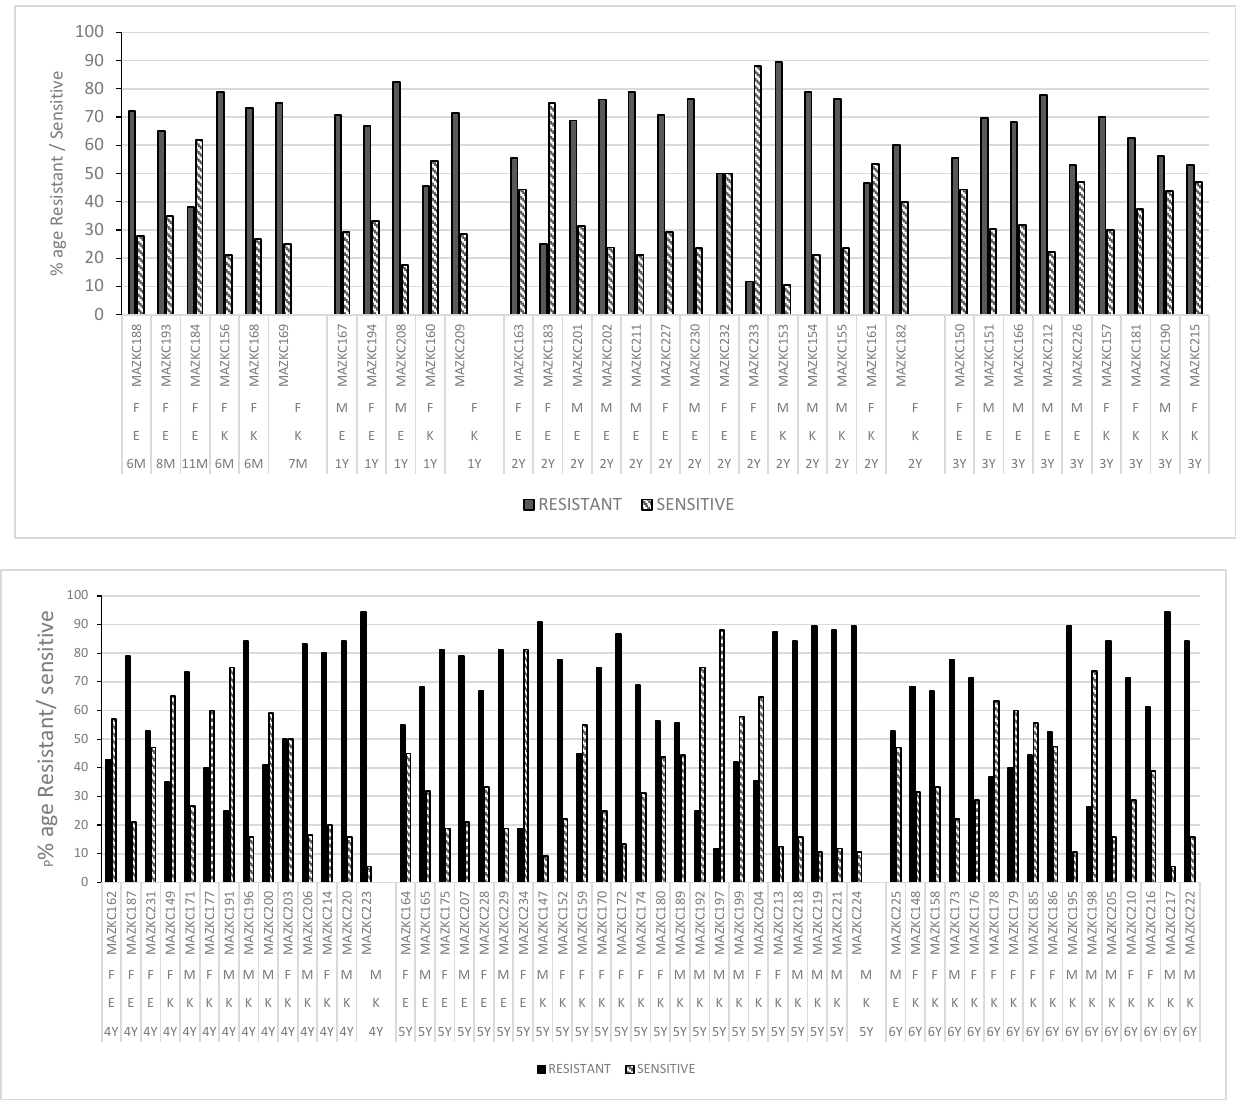
Figure 5. Percentage of antibiotic resistance/sensitivity (against tested antibiotics) in Escherichia and Klebsiella in relation to age and gender from pediatric patients’ (aged 0–6 years) samples at Children Hospital. E = Escherichia ; K = Klebsiella ; F = Female; M = Male; M = Age in Months, Y = Age in years (1 Year, 2 Years, 3 Years, 4 Years, 5 Years, 6 Years) .